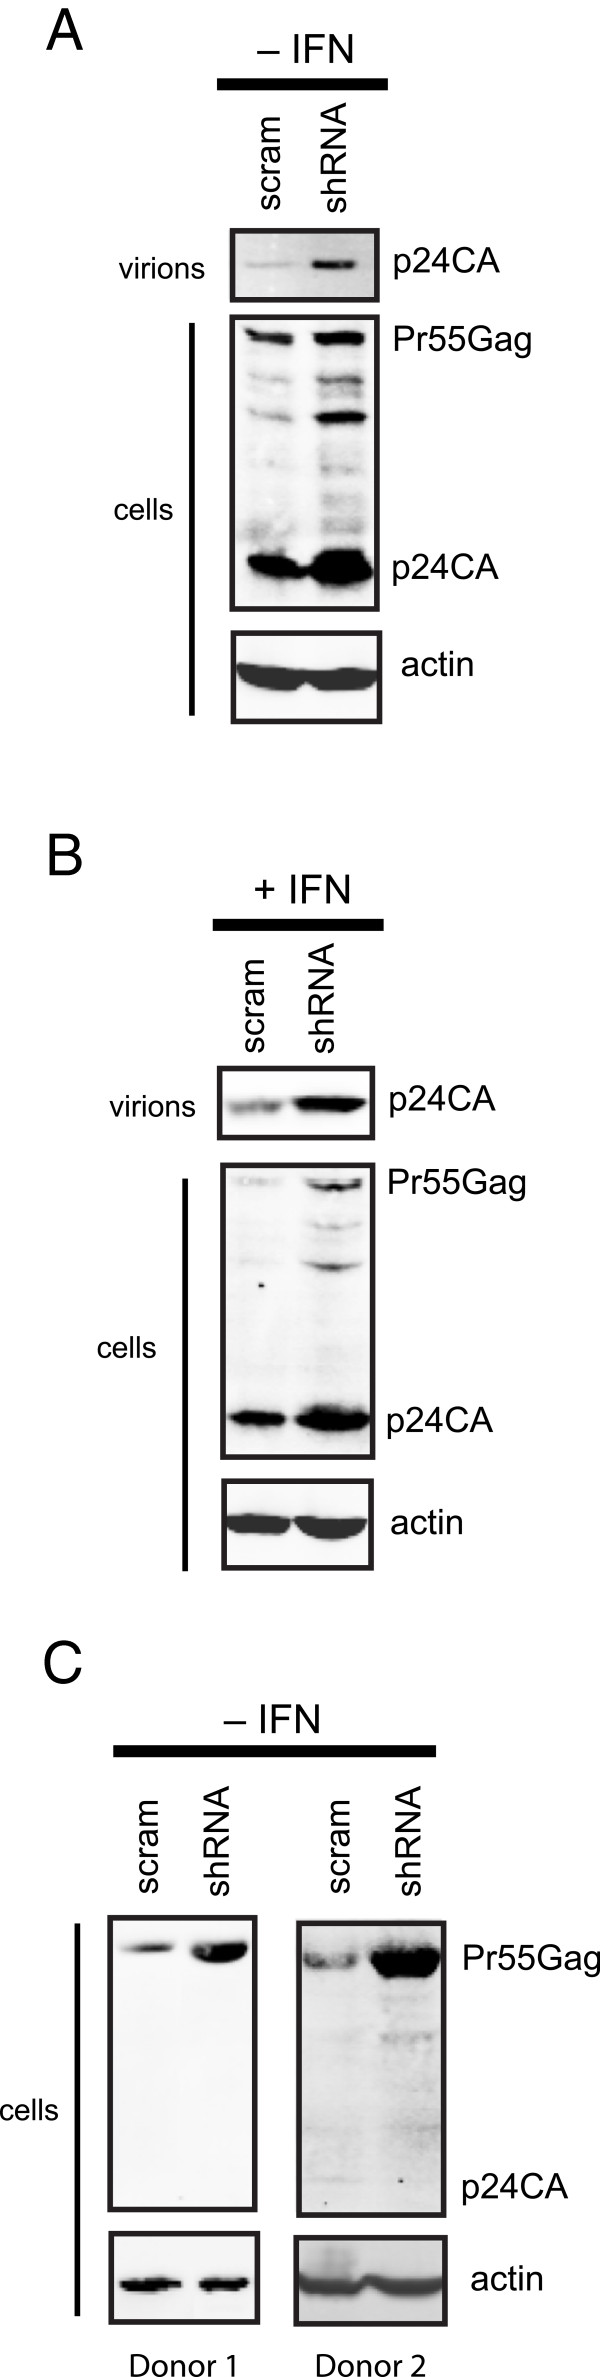
Endogenous HERC5 inhibits intracellular Gag protein production. A, 293T cells were co-transfected with pR9 and either pScram or pHERC5shRNA. Forty-eight hours after transfection, cell lysates were subjected to Western blotting using anti-p24CA or anti-β-actin as a loading control. B, Cells were transfected as in part A for 24 hours and then treated with 500 units/ml of IFN-β. Sixteen hours after IFN-β treatment, cell lysates were subjected to Western blotting using anti-p24CA or anti-β-actin as a loading control. Data shown in panels A and B are representative of at least three independent experiments. C, Human monocyte-derived macrophages from two different donors were transfected as in panel A. Seventy-two hours after transfection, cell lysates were subjected to Western blotting using anti-p24CA or anti-β-actin as a loading control.